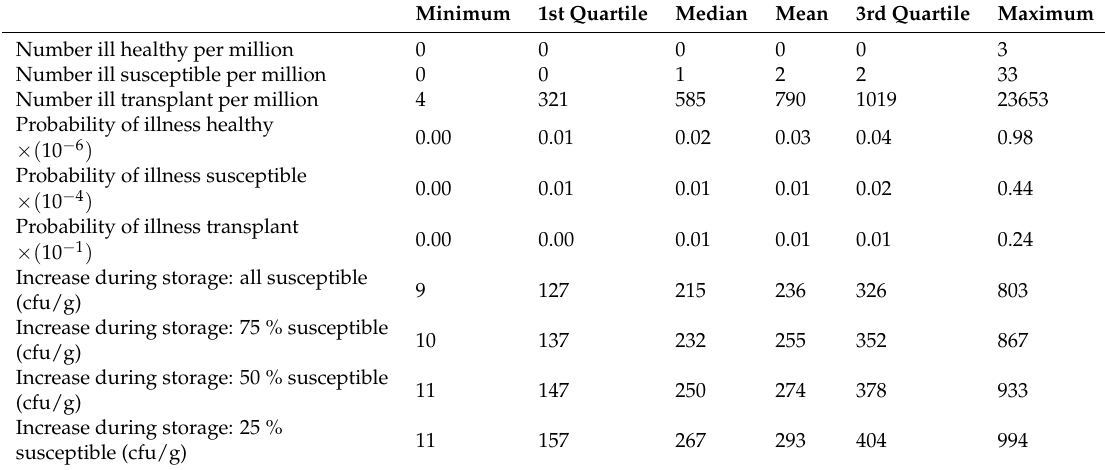
Table 4. Results for quantitative microbial risk assessment of L. monocytogenes at the consumer level in cultured milk